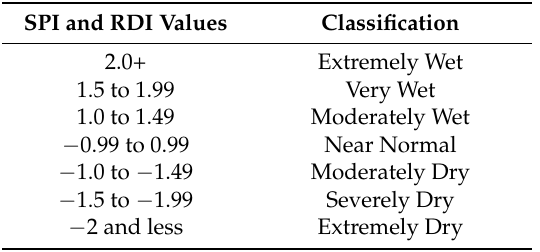
Table 1. Classification of drought index from SPI and